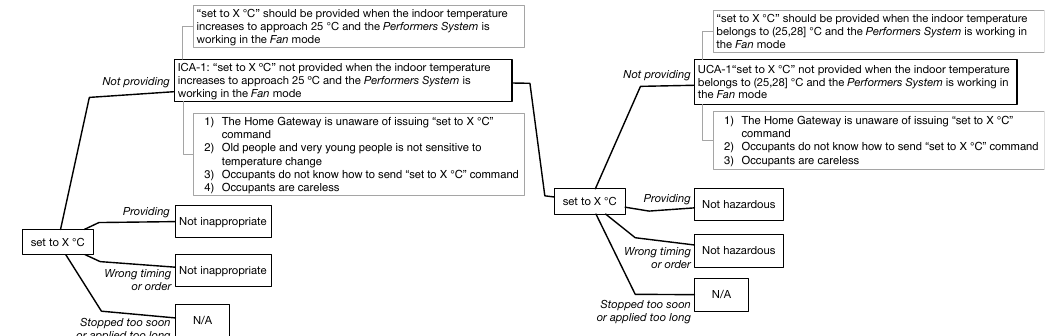
Figure 9. The analysis results for the control action “set to X ◦ C”.